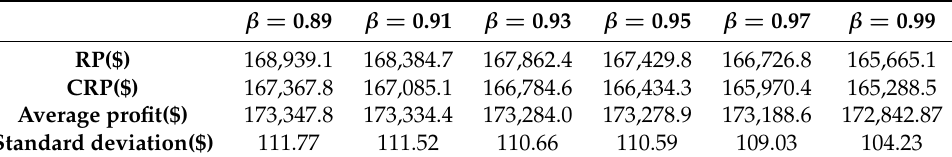
Table 3. RP, CRP, average profit and standard deviation under different confidence levels.